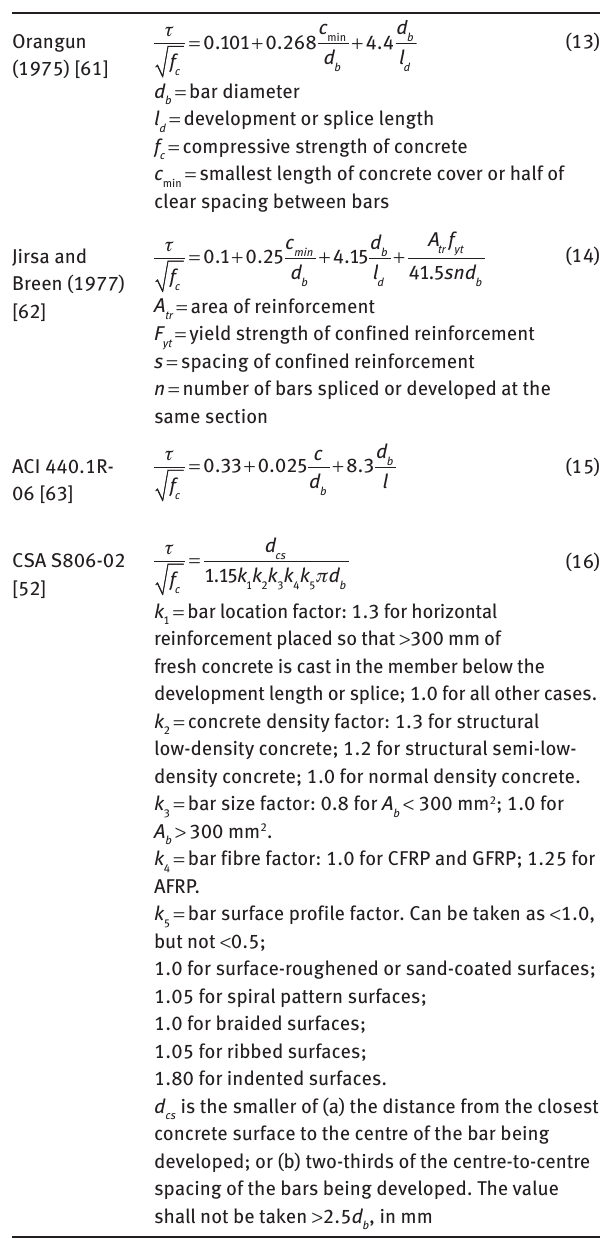
Table 2: Bond strength equations from the literature and international design